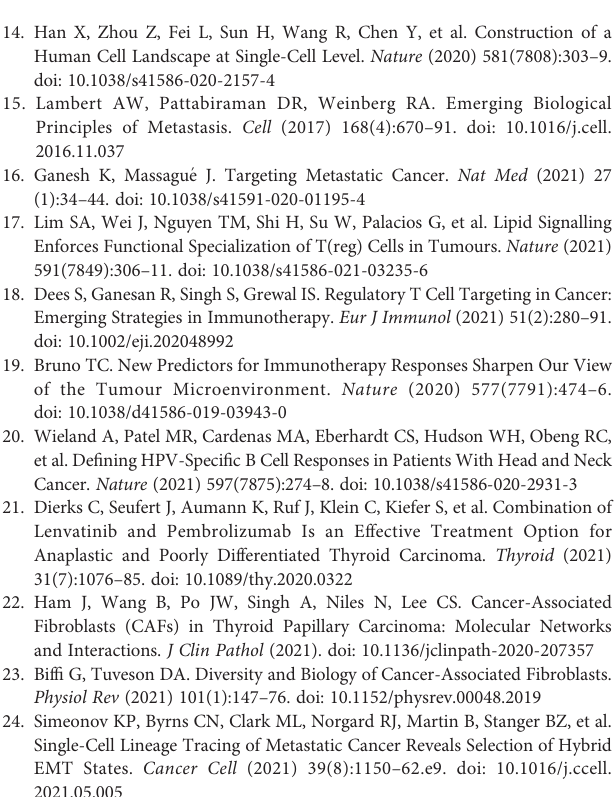
Supplementary Figure S1 | Expression levels of top20 genes in MEFCs (A) and NFECs (B) on the t-SNE plot, with each cell colored based on the relative normalized